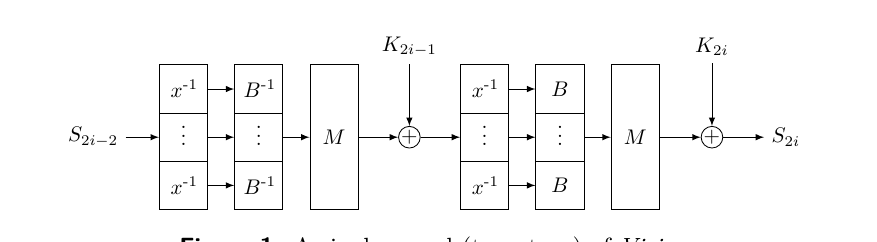
Figure 1: A single round (two steps) of